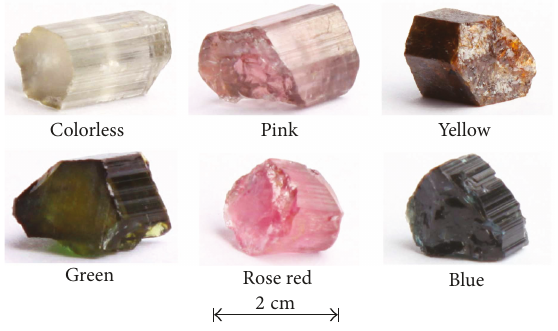
Figure 1: Tourmaline